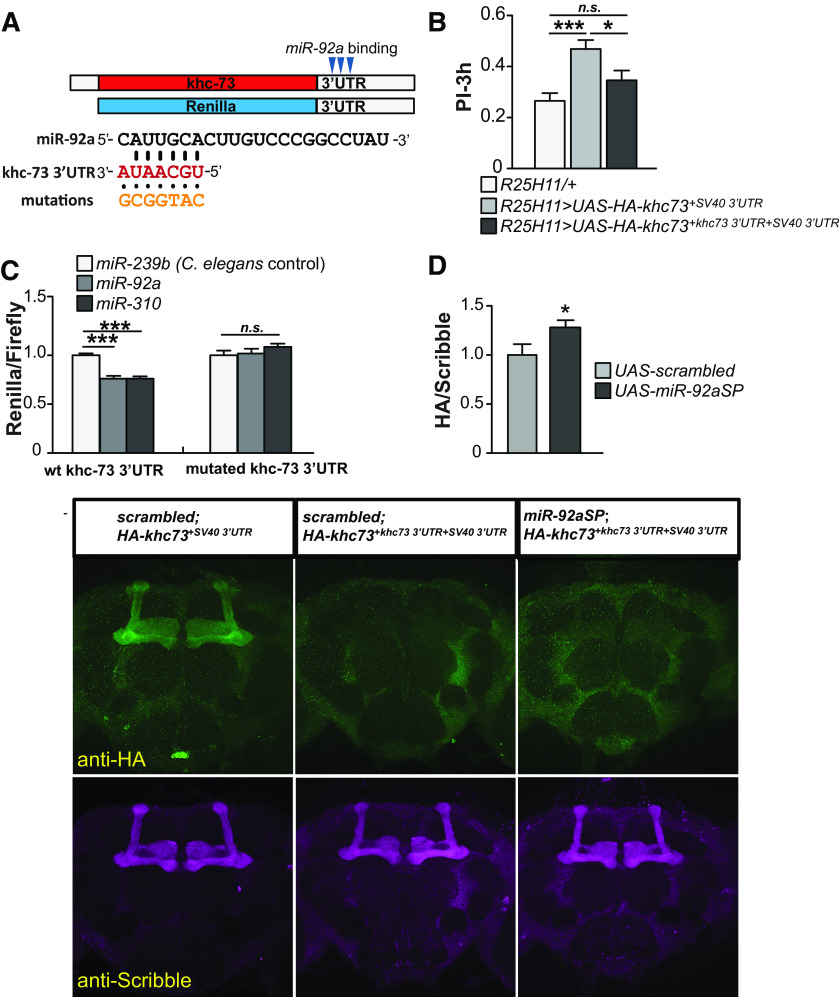
Memory performance of flies overexpressing khc73 with and without the endogenous 3’UTR. A, Three predicted miR-92a binding sites in the endogenous 3’UTR are schematized. Renilla luciferase reporter was cloned upstream of the 2.7-kb khc73 3’UTR and used for the experiment shown in C. Nucleotides with predicted miR-92a binding are shown in red font. All three miR-92a sites were altered to generate a mutant khc73 3’UTR that is unresponsive to miR-92a repression (shown with orange font) as a negative control for luciferase experiments. B, Overexpressing khc73 with the endogenous 3’UTR eliminates the memory enhancement gained without the 3’UTR. Expression of HA-tagged khc73 transgenes with or without 2.9 kb of its own 3’UTR confers normal and enhanced memory performance, respectively. PIs are the mean ± SEM with n = 14. One-way ANOVA followed by Bonferroni’s post hoc tests, *p < 0.05, ***p < 0.001. C, Overexpressing miR-92a represses expression of a khc73 3’UTR luciferase reporter. The Renilla luciferase signal was normalized to firefly luciferase for each transfection. C. elegans miR-239b served as negative and Drosophila miR-310 as positive controls. Renilla/firefly ratios were normalized to negative controls for each reporter construct. Relative repression ratios ± SEM with n = 9. One-way ANOVA followed by Bonferroni’s post hoc tests, ***p < 0.001, n.s., not significant. wt: wild-type. D, miR-92a inhibition derepresses HA-KHC73 signal. HA-Khc73 transgenes with or without the endogenous 2.9-kb 3’UTR element were overexpressed in MBn using the R13F02-GAL4 driver. The presence of the endogenous 3’UTR constraints the HA-KHC73 signal. Very weak signals in the mushroom bodies were detected (middle column) and quantified (bar plot). This weak signal was significantly derepressed when the miR-92aSP was co-expressed (right column). The bar plot shows the quantification of R13F02>scrambled, HA-khc73 + 3’UTR versus R13F02>miR-92aSP, HA-khc73 + 3’UTR brains. ROI was taken from the horizontal lobes by reference to anti-Scribble signal. HA/Scribble ratios were used to minimalize brain to brain variability. Ratios are the mean ± SEM with n = 26–30. Two-tailed, two-sample Student’s t tests, *p < 0.05.